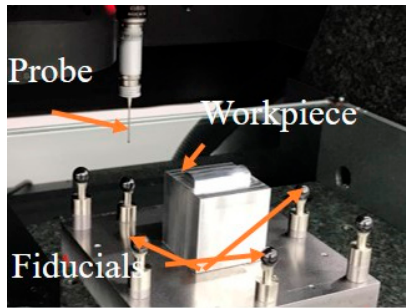
Figure 6. Machining surface by a machine tool.